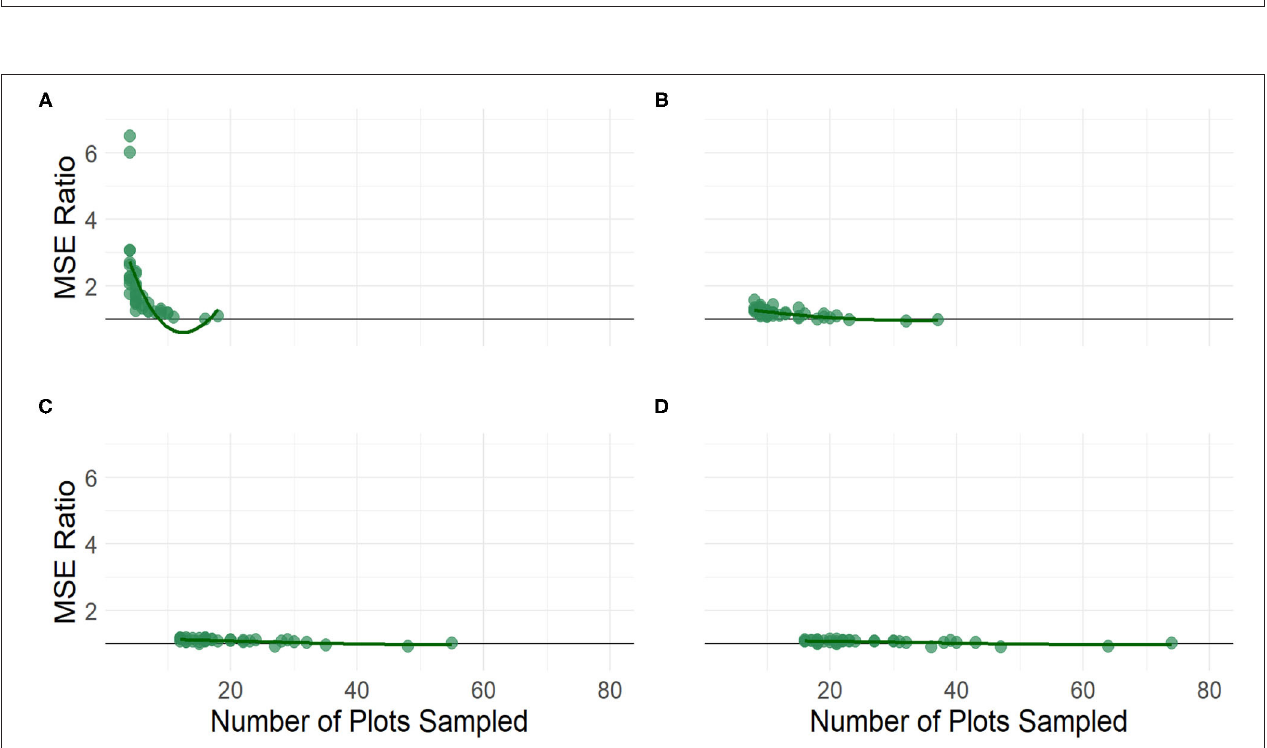
FIGURE 9 | The MSE ratio of the GREG to the GREGORY when estimating the average trees per acre at the county level by sample size across the following sampling intensities: (A) 2%, (B) 4%, (C) 6%, and (D) 8%. A loess smoother is included.